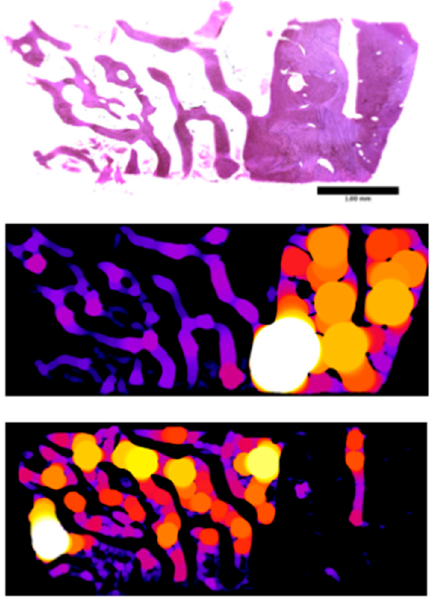
Figure 5. From top to bottom: undecalcified section of the bone specimen, acid fuchsine-toluidine blue staining, 40× magnification; graphic appearance of trabecular thickness index (Tb.Th) obtained with the BoneJ plug-in of ImageJ software, which generates circles inside trabeculae; graphic